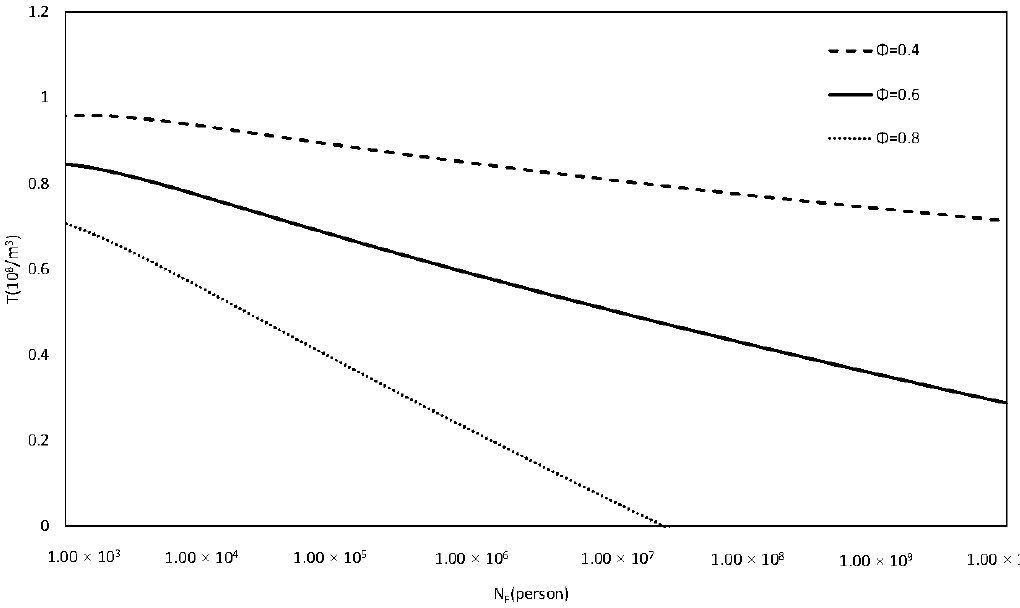
Figure 2. Relation of transaction volume T to rural population N F .